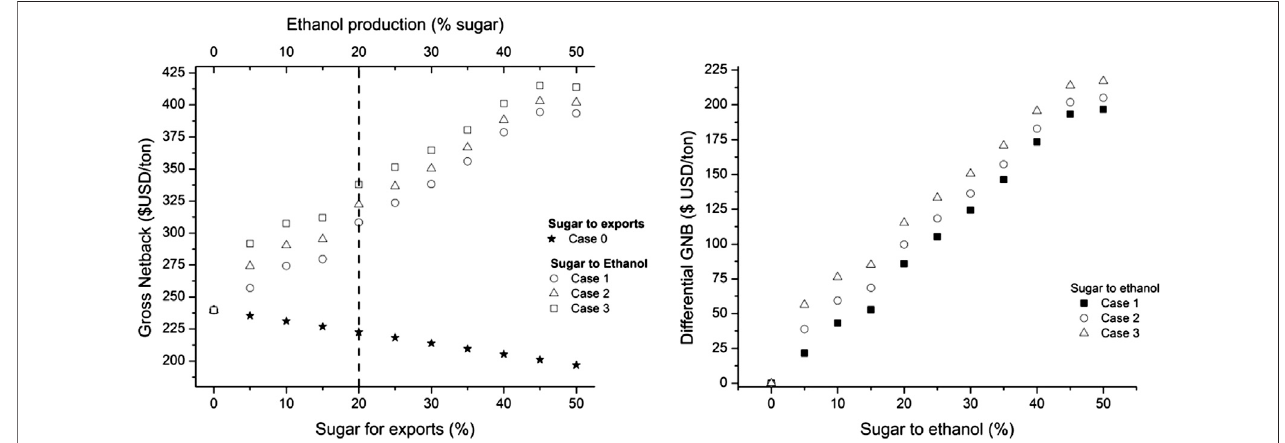
FIGURE 4 | Gross netback (GNB) in scenario 1 for sugar to exports (left) and scenario 2 for sugar to ethanol and its differential (right) .